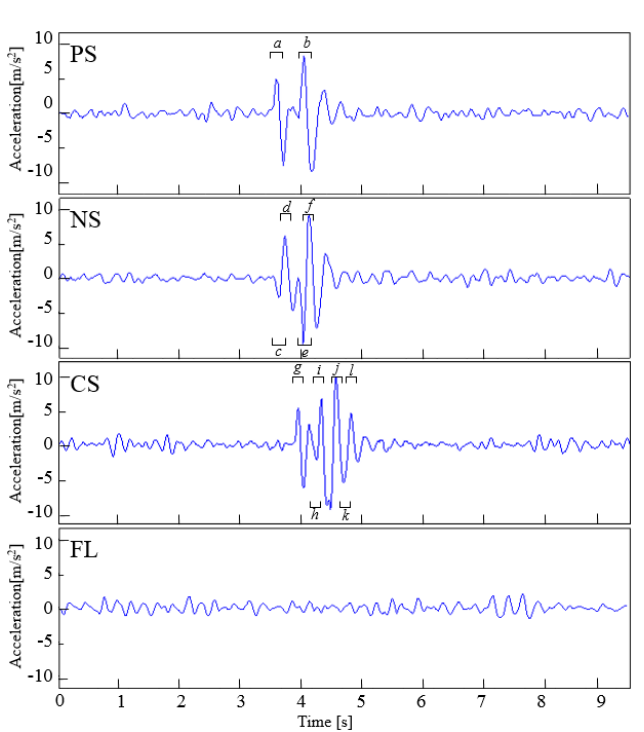
Figure 3: Acceleration signals in x-axis from smartphone on the hip